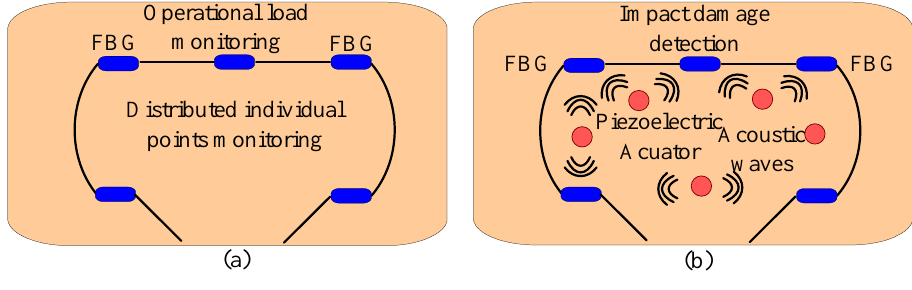
Figure 4. Two-dimensional structure monitoring. (a) operational load monitoring and (b) impact damage detection with hybrid use of FBG and acoustic actuators.